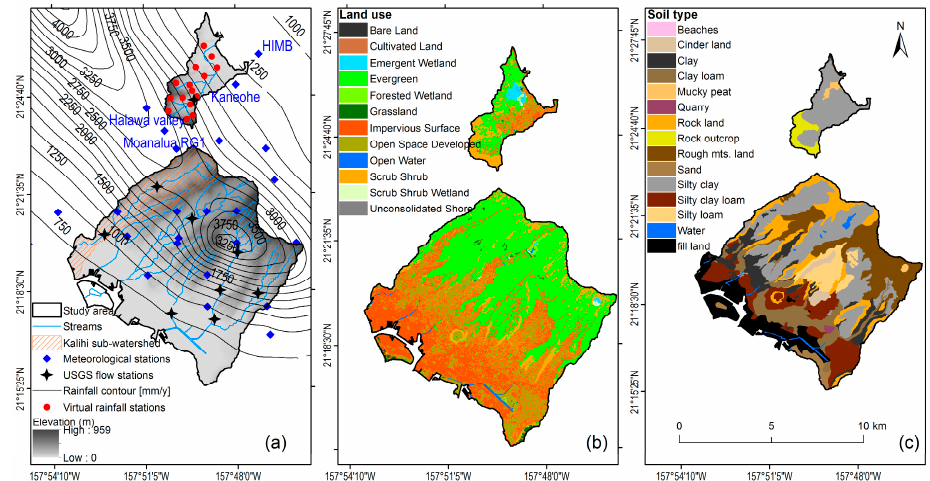
Figure 2. Heeia and Nuuanu area watersheds: ( a ) digital elevation model with hydro-meteorological stations and annual rainfall isohyet (in mm); ( b ) land use; and ( c ) soil type.